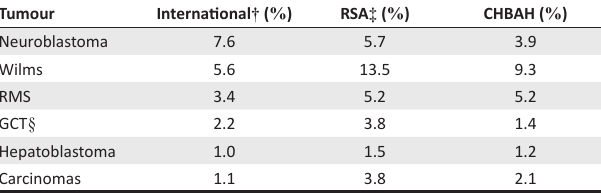
TABLE 5: Comparison of relative tumour frequencies in the different regions.